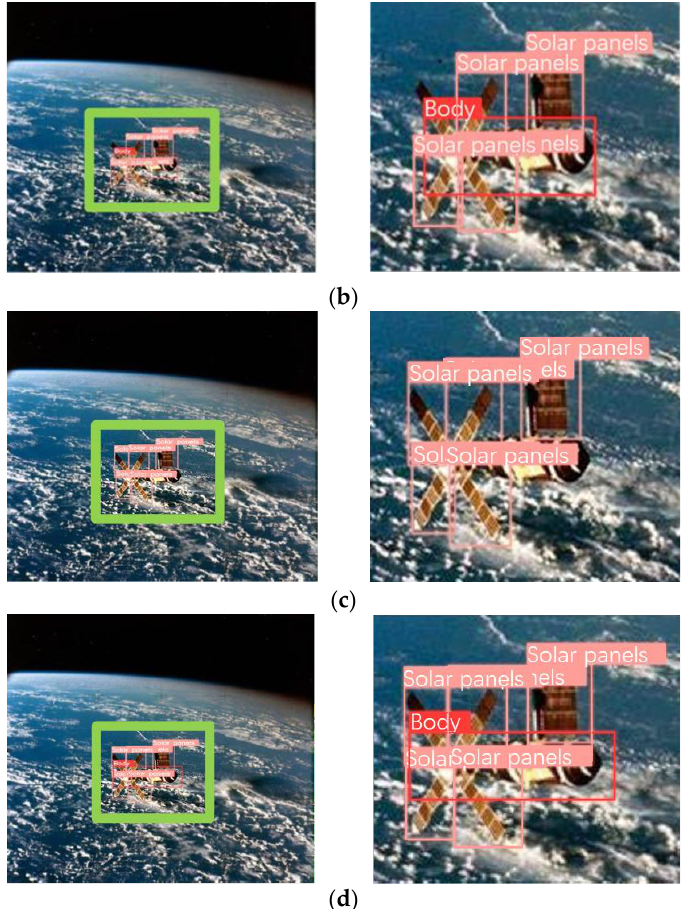
Figure 9. The experimental results of the comparison method under fully illuminated conditions. The left is the detection image. The right is a close-up of the test results. ( a ) YOLOv5-MobileNetv3 detection results. ( b ) YOLOv5-ShuffleNetv2 detection results. ( c ) YOLOv5-GhostNet detection results. ( d ) YOLOv5-GMB detection results.